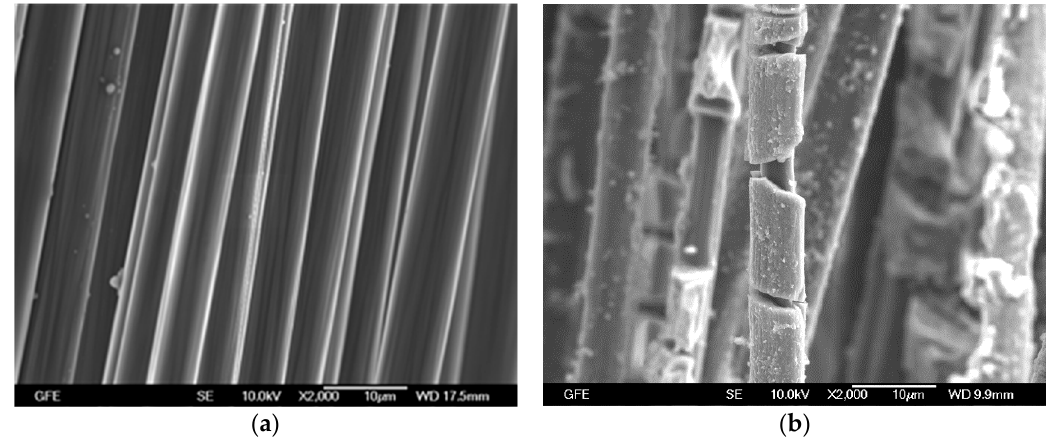
Figure 5. SEM images of unpolarized carbon fibres ( a ) and a polarized carbon fibre ( b ).